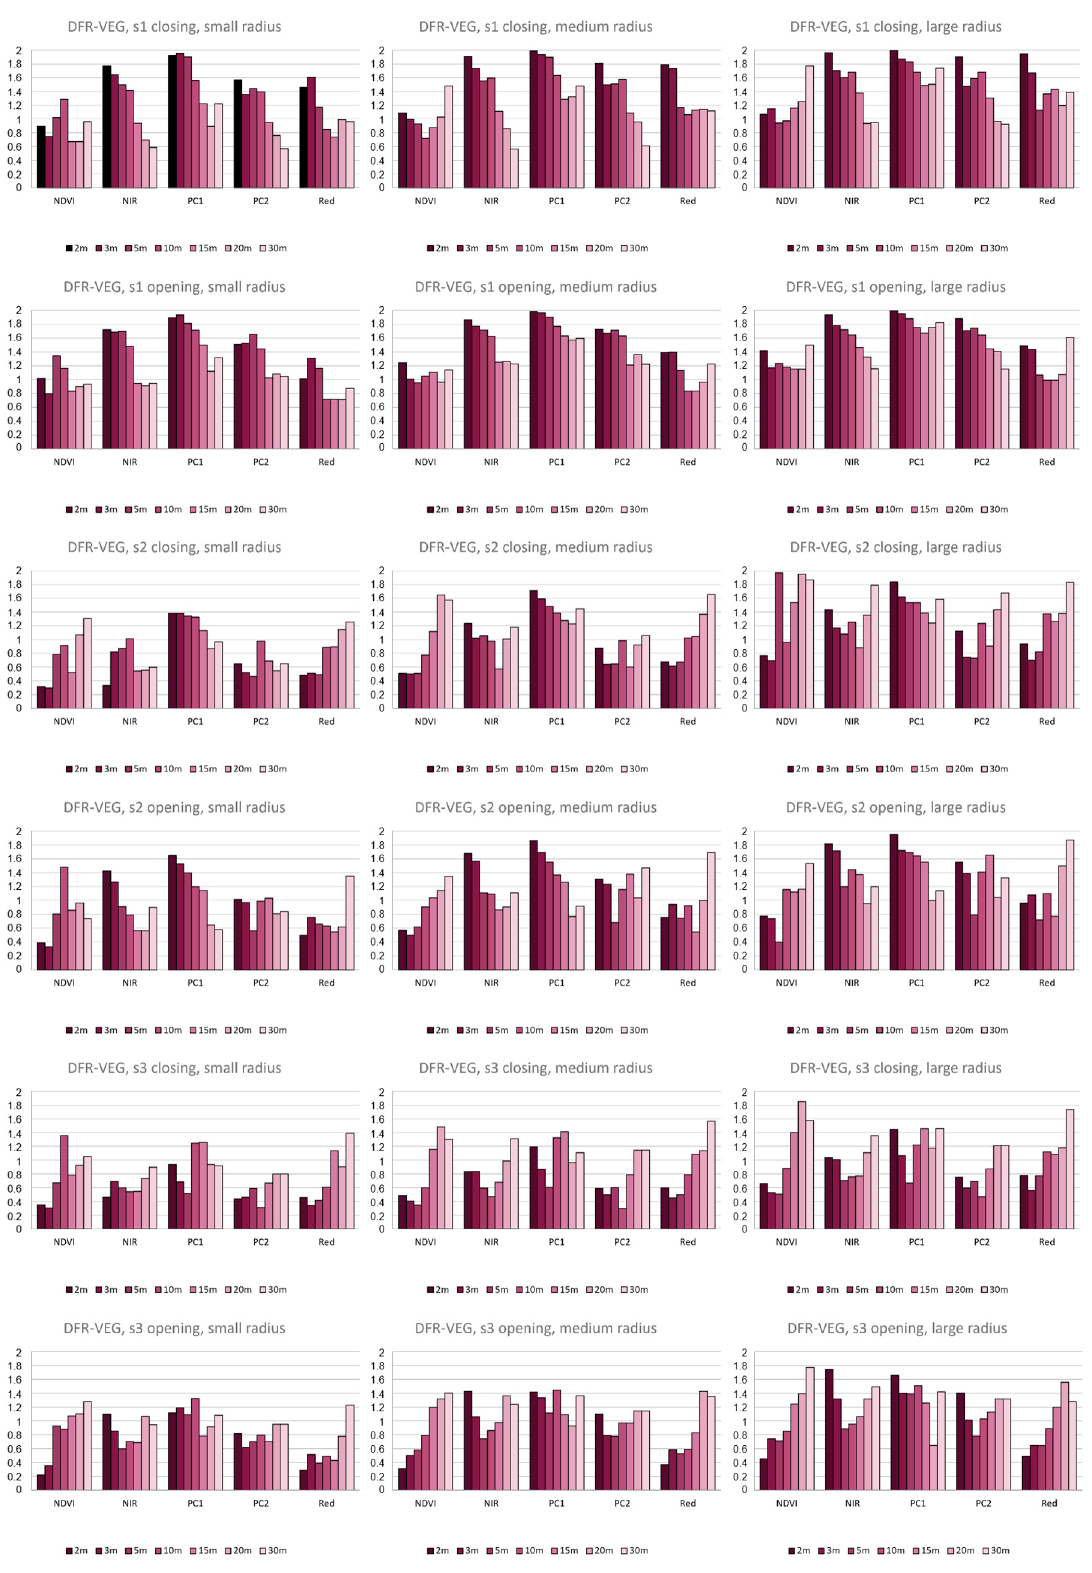
Figure 4. J–M distance diagrams for test fields for the deciduous forest/low vegetation class pair (DFR/VEG).